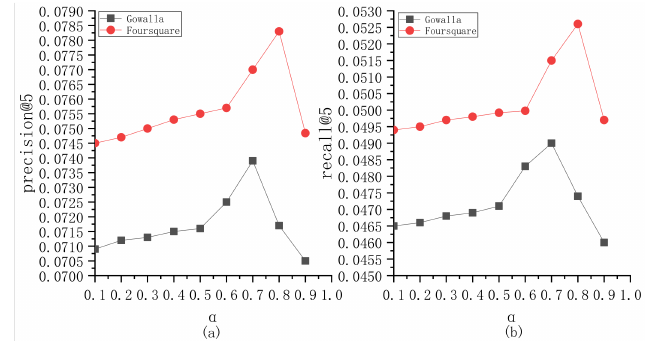
Figure 5. The sensitivity analysis of α . ( a ) precision @5; ( b ) recall @5.